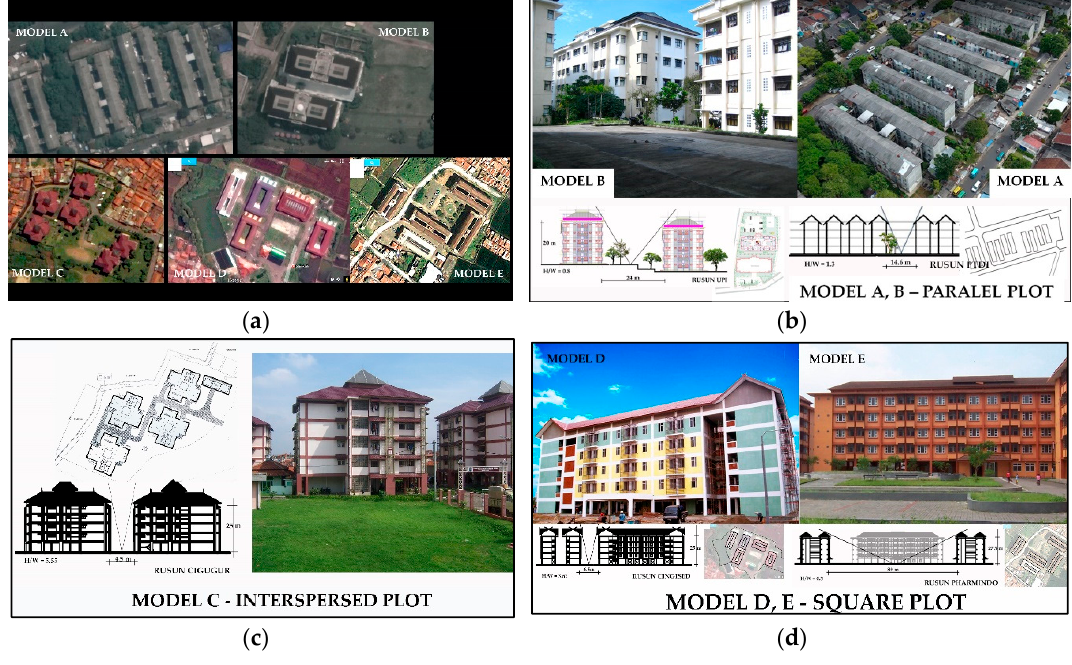
Figure 1. Rusun as case study in Bandung, there are: ( a ) satellite imagery from google earth; ( b ) parallel plot which are Model A and B; ( c ) interspersed plot: Model C; ( d ) Square Plot: Model D and E.